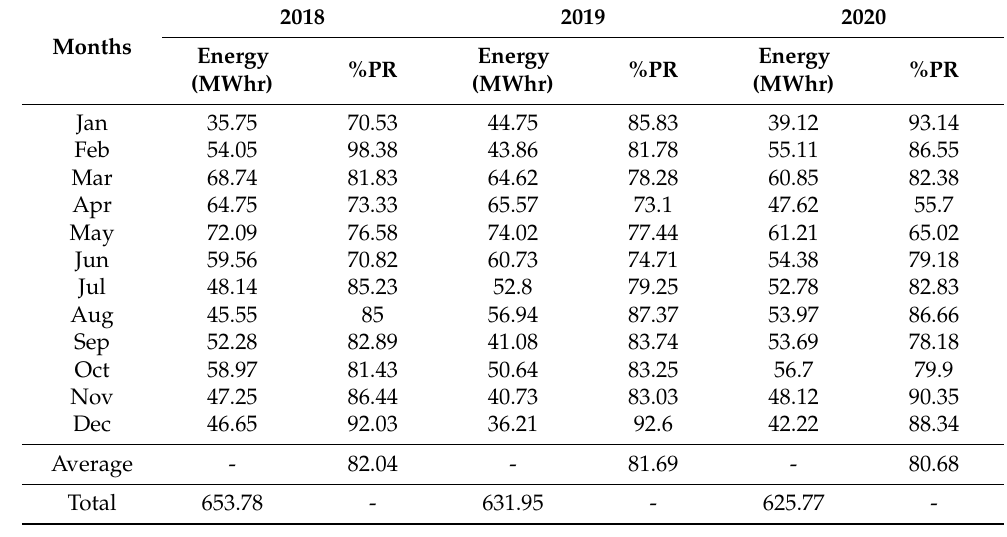
Table 8. Comparison of Generated Energy in 2018, 2019, and 2020 of 467.2 kWp Plant (P 1 + P 2 + P 3 ).